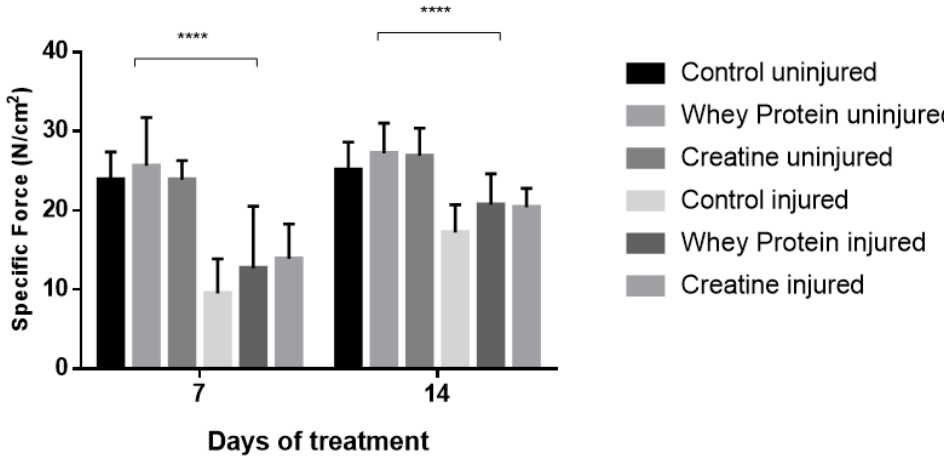
Figure 2. Specific forces (sPo) of uninjured and injured EDL muscles from rats treated with standard rat chow- (CON-), whey protein- (WP-), or creatine- (CR-) supplemented rat chow at day 7 and 14 post-injury. Values are mean ± SD. **** ( p < 0.0001) significantly different from contralateral values.